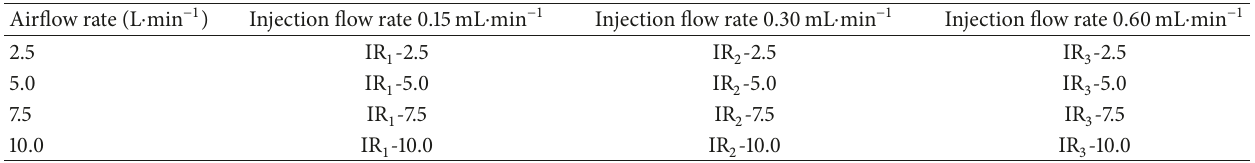
Figure 1: (a) Schematic diagram of the experimental equipment, used to prepare chitosan microspheres, developed in our lab: (1) electronic microcontroller, (2) injection zone, (3) dripper, (4) stirrer, (5) rotameter, and (6) pump. (b) The magnification, items 1 and 2, of the experimental equipment, used to prepare chitosan microspheres. Table 1: Chitosan microspheres manufacturing